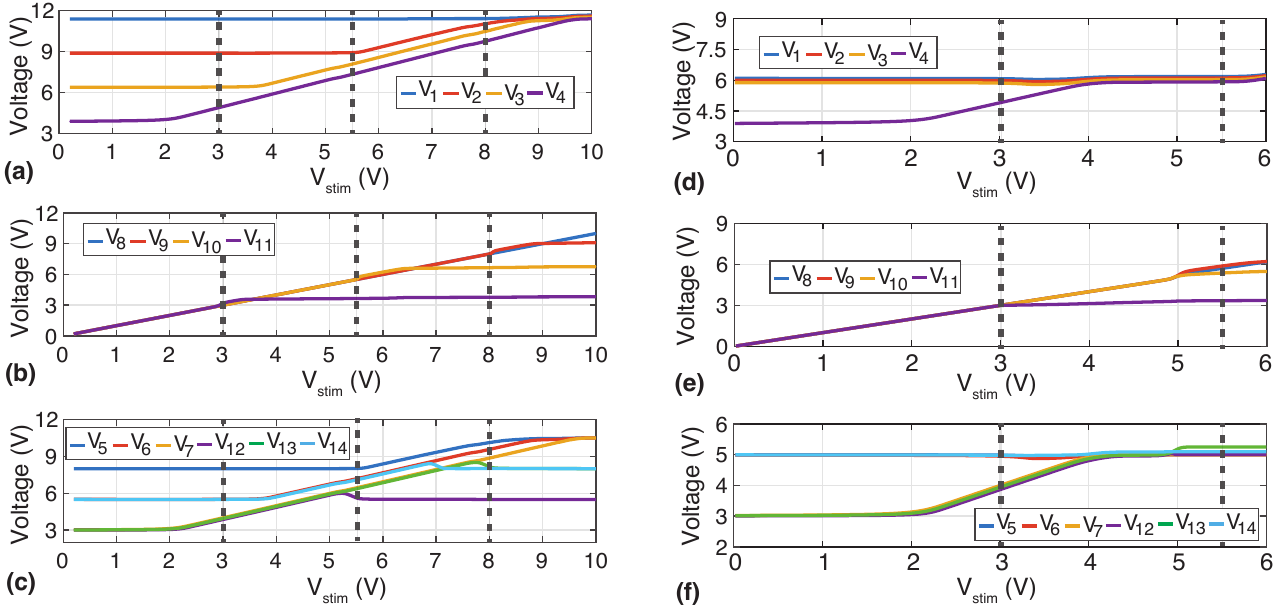
Figure 7. Evolution of the voltages at the nodes of the HCVC, as depicted in Figure 6. ( a – c ) The load resistance, R s , is swept from 10 Ω to 5k Ω , V DDH = 13V, and N a = 4. ( d – f ) The load resistance, R s , is swept from 0 to 3k Ω , V DDH = 8V, and N a =